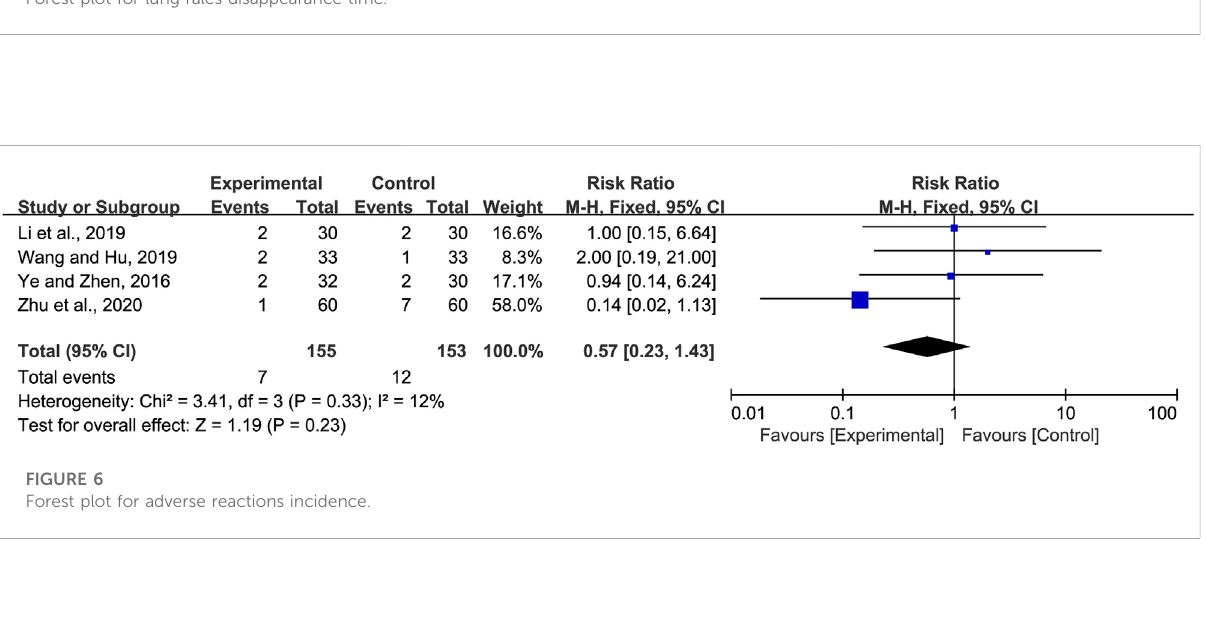
FIGURE 5 Forest plot for lung rales disappearance time.